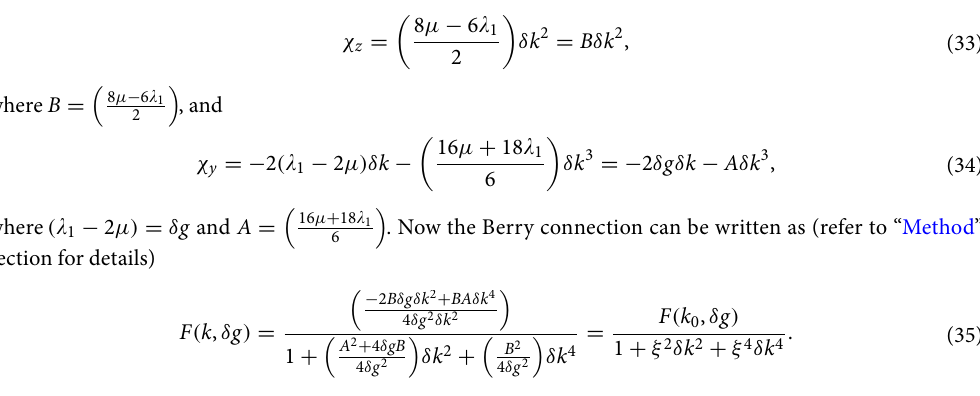
2 µ , solid line in Fig. 10, indicate the = 0 (CP-1) and w 1 (CP-2) = = (cid:31) µ 1 . Therefore it indicate the TQPT between these gapless phases = − µ represent fixed points in the flow diagram. = 0 and also can be observed at the =